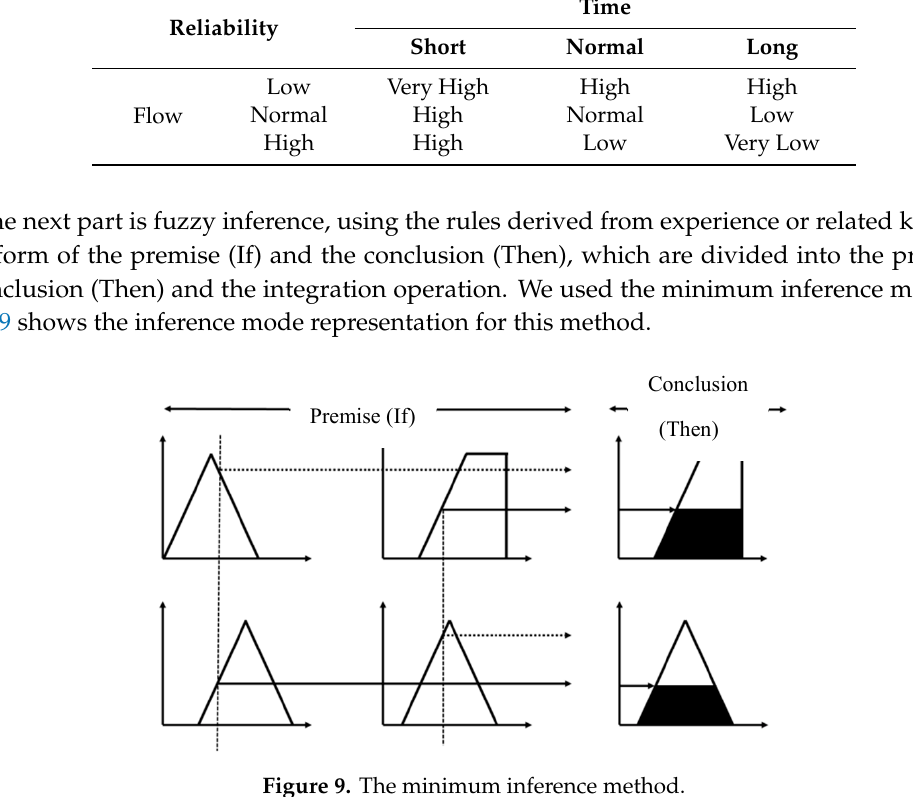
Figure 9. The minimum inference method.